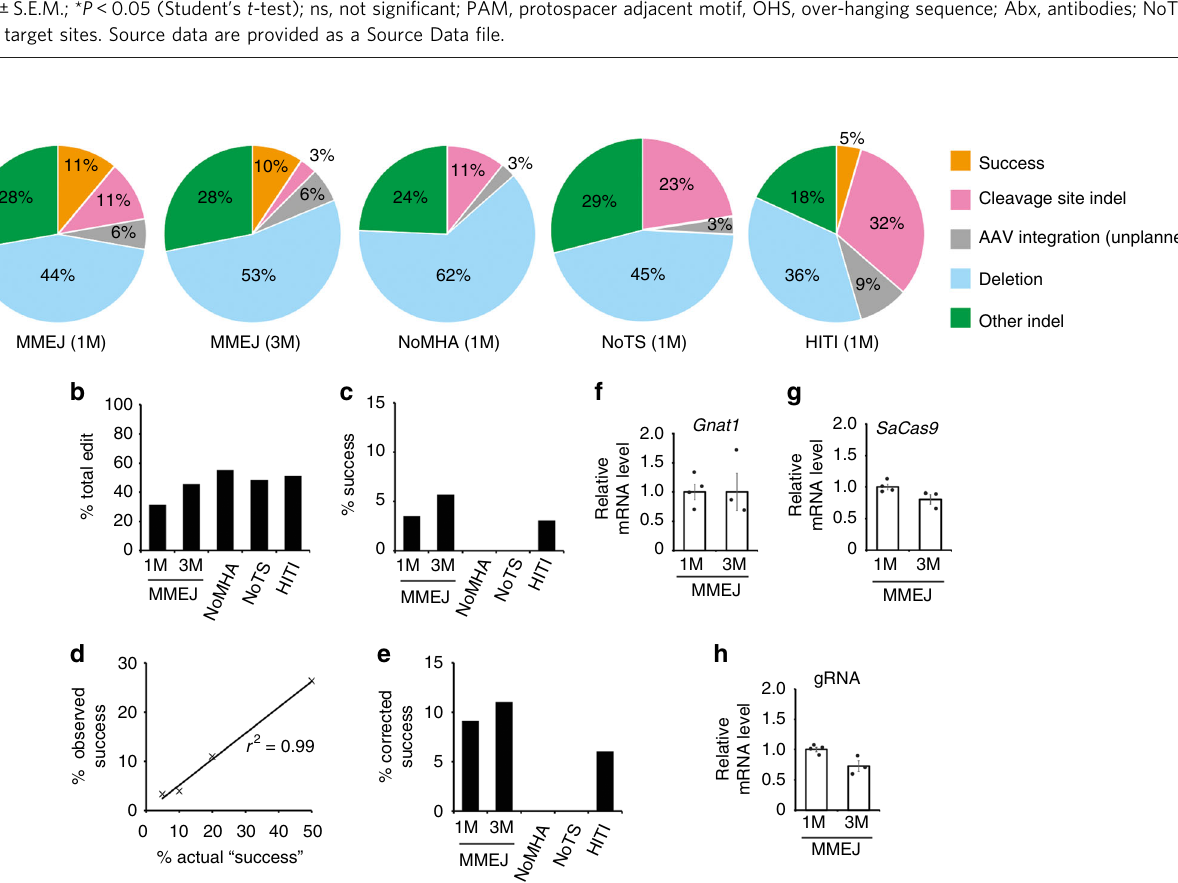
Fig. 2 In vivo assessment of the on-target site. a Breakup of sequencing results of the on-target site in the genome-edited clones ampli fi ed from the retina collected 1 M or 3 M post-injection. MMEJ, NoMHA, and NoTS represents injection of protype MMEJ vector, MMEJ vector without microhomology arms, and MMEJ vector without gRNA target sites, respectively. HITI represents homology-independent targeted integration. See Supplementary Fig. 3 for vector map. Total clones sequenced were 57, 70, 67, 64 and 86 for MMEJ (1 M), MMEJ (3 M), NoMHA (1 M), NoTS (1 M), and HITI (1 M), respectively. Success indicates successful mutation replacement. Cleavage site indel represents indels in either gRNA cleavage site without replacement of IRD2 mutation (see Online Methods for detail). Note, co-existing mutation replacement and cleavage site indels, which is expected to occur as a consequence of repeated cleavage at the gRNA site was not observed. b Total editing rate. Percentage of clones that showed any sign of genome editing among the total clones analyzed. c Absolute success rate in the rods, assuming the cells comprise 75% of retinal neurons. d Estimation of detection ef fi ciency of Success allele by subcloning and PCR. Observed % Success (vertical axis) were obtained by distinguishing the identity of the clones derived from PCR products ampli fi ed from mixture of Success and unedited mutant DNA templates at various ratio (horizontal axis). Total clones sequenced in this experiment were 61, 52, 64 and 61 for 5%, 10%, 20%, and 50% mixtures (rate of Success DNA versus total DNA), respectively. Intercept = − 0.154, slope = 0.528, r 2 = 0.99. e Estimated absolute success rate in the rods corrected for by the detection ef fi ciency of Success alleles relative to unedited mutant allele, assuming 75% of retinal neurons are the rods. f RT-PCR of Gnat1 at 1 M ( N = 4) and 3 M ( N = 3). g RT-PCR of SaCas9 at 1 M ( N = 4) and 3 M ( N = 3) post-injection. h . RT- PCR of gRNA at 1 M ( N = 4), and 3 M ( N = 3) post-injection. Data represent the mean ± S.E.M. Source data are provided as a Source Data fi